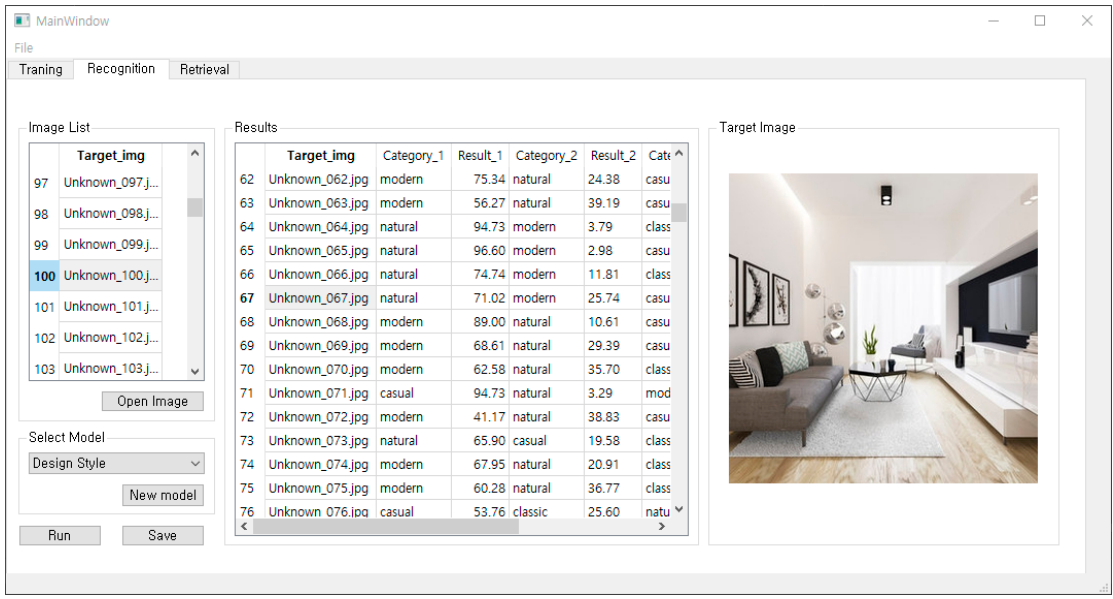
Figure 9. Prototype application for interior design style recognition with a trained model.